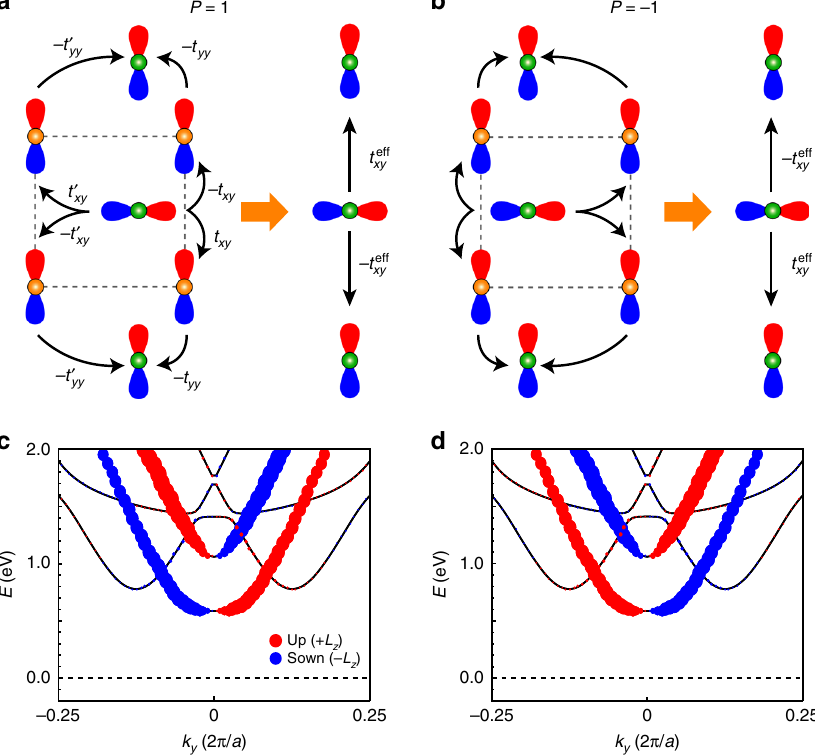
Fig. 3 Ferroelectrically driven orbital Rashba effect. a , b The emergence of an asymmetric inter-orbital hopping that is induced by a ferroelectric ′ xy t ′ yy p x orbital to the nearest-neighbor Sn- polarization, which results in the orbital Rashba effect. An effective inter-orbital hopping ( t eff xy ¼ t xy t yy (cid:2) t E Sn (cid:2) E Te ) from the Sn- p y -axis is allowed by the ferroelectric displacement. The sign of the effective hopping is determined by the polarization direction. The y orbital along the dumbbells represent p x and p y orbitals of Sn and Te atoms, whose atomic energies are E Sn and E Te , respectively; the blue (red) colored region means a positive (negative) value of the p orbital wave-function. Green balls, Sn; Orange balls, Te. c , d The orbital angular momentum texture that was obtained via density functional theory calculations in the absence of spin-orbit coupling depends on the polarization direction, which supports the presence of the ferroelectrically coupled orbital Rashba effect. As predicted in our analytic model, the orbital angular momentum is an odd function with respect to k y and the orbital-split-off states show opposite signs at the same k point. From the close correlation between Berry curvature (BC) and orbital angular momentum, the orbital Rashba effect can bring a similar BC distribution, possibly leading to the BC dipole along the k y